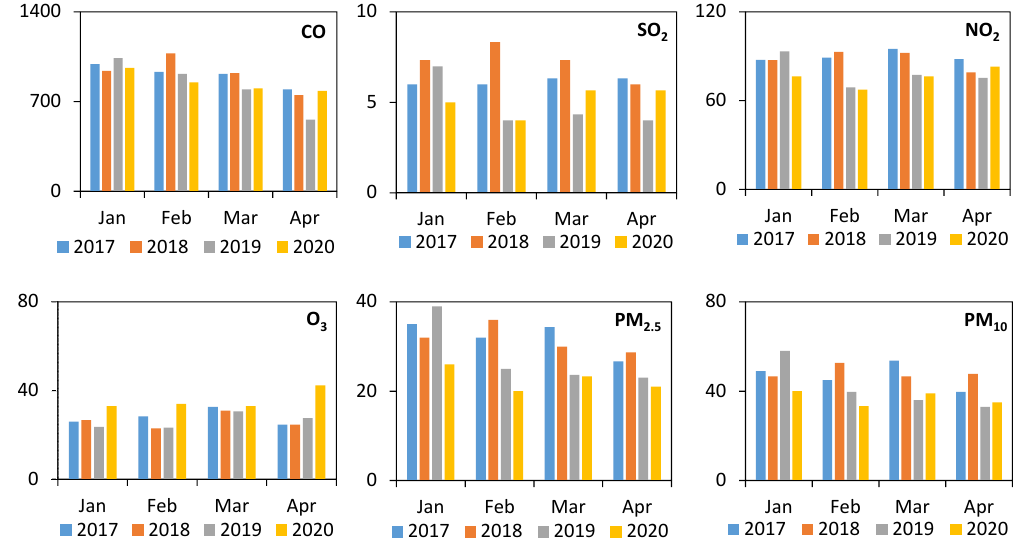
Figure 1. Average roadside pollutant concentrations measured at the three roadside air quality monitoring stations. All pollutants units are in μ g/m 3 .